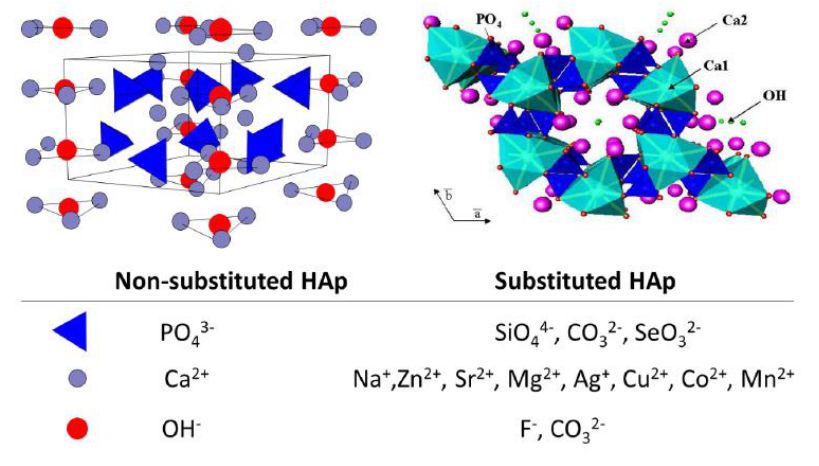
Figure 1. The Ca 2+ , PO 43 − and OH − in the crystal structure of hydroxyapatite can be substituted by many other ions [12].